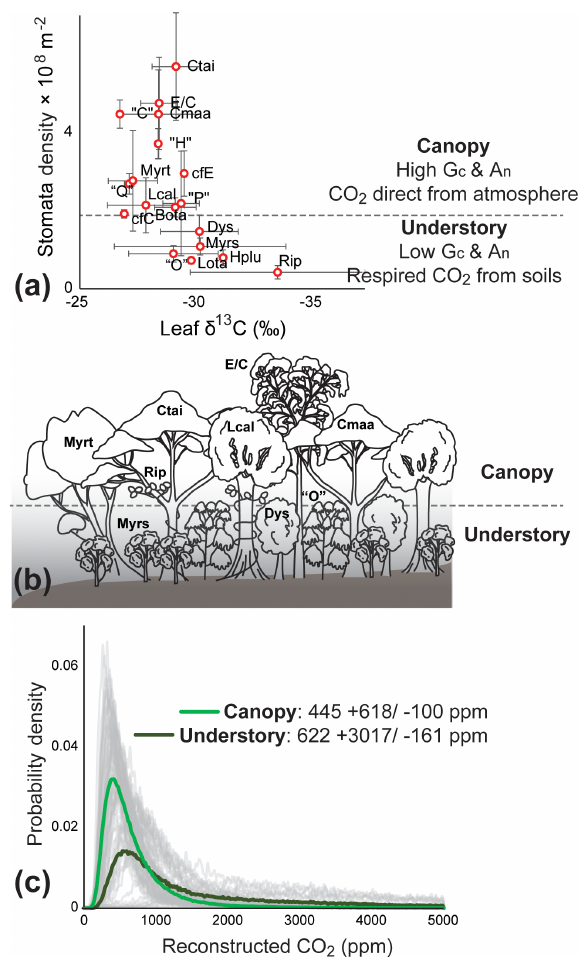
Figure 2. Foulden Maar paleoecology and atmospheric CO 2 re- constructions. (a) δ 13 C values and stomatal density (error bars representing ± 1 σ ) from the fossil leaves of Foulden Maar pro- vide constraints to distinguish canopy leaf types from under- story because understory leaves tend to have a high range of δ 13 C and low cell density (Graham et al., 2014; Bush et al., 2017). (b) Paleoecological reconstruction of the dense rainfor- est at Foulden Maar with a canopy comprising Litsea calicari- oides (Lcal), Cryptocarya taieriensis (Ctai), C. maarensis (Cmaa), cf. Elaeocarpaceae/Cunoniaceae (E/C), and cf. Myrtaceae (Myrt) and an understory comprising cf. Myrsine (Myrs), cf. Ripogonum (Rip), cf. Dysoxylum (Dys), and leaf type “O”. Hedycarya plu- visilva (Hplu), Laurelia otagoensis (Lota), Beilschmiedia otagoen- sis (Bota), cf. Cryptocarya (cfC), cf. Endiandra (cfE), and leaf types “C”, “H”, “P”, and “Q” could not be ecologically placed with cer- tainty. (c) Probability density distributions of C a reconstructions from canopy (thick light green line) and understory components (thick dark green line) using a gas-exchange model (Franks et al., 2014). Grey curves represent the probability distribution of 10000 Monte Carlo reconstructions on a single fossil